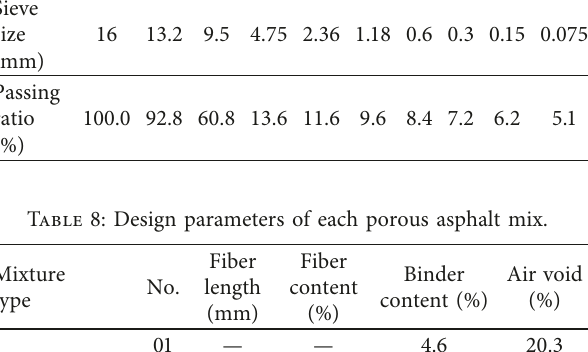
Table 7: Porous asphalt mixture gradation. Sieve